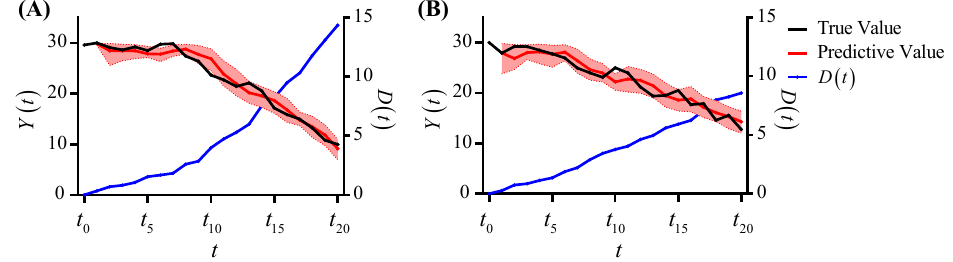
Figure 5. The prediction results of under different c ga . ( A ) Setting 1. ( B ) Setting 2. Figure 6 shows the prediction results of Settings 3, 4, and 5. In these three settings, the effect of emotional impacts is explored. In Setting 3, as shown in Figure 6A, the pink